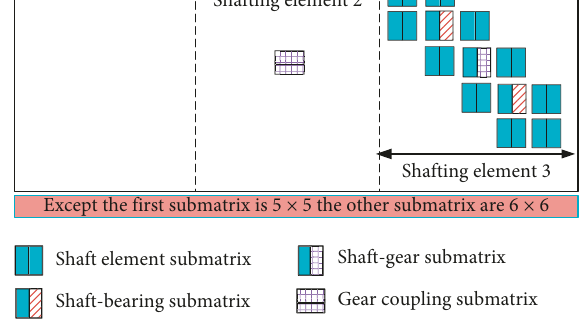
Figure 8: Schematic of the assembly rules of the overall